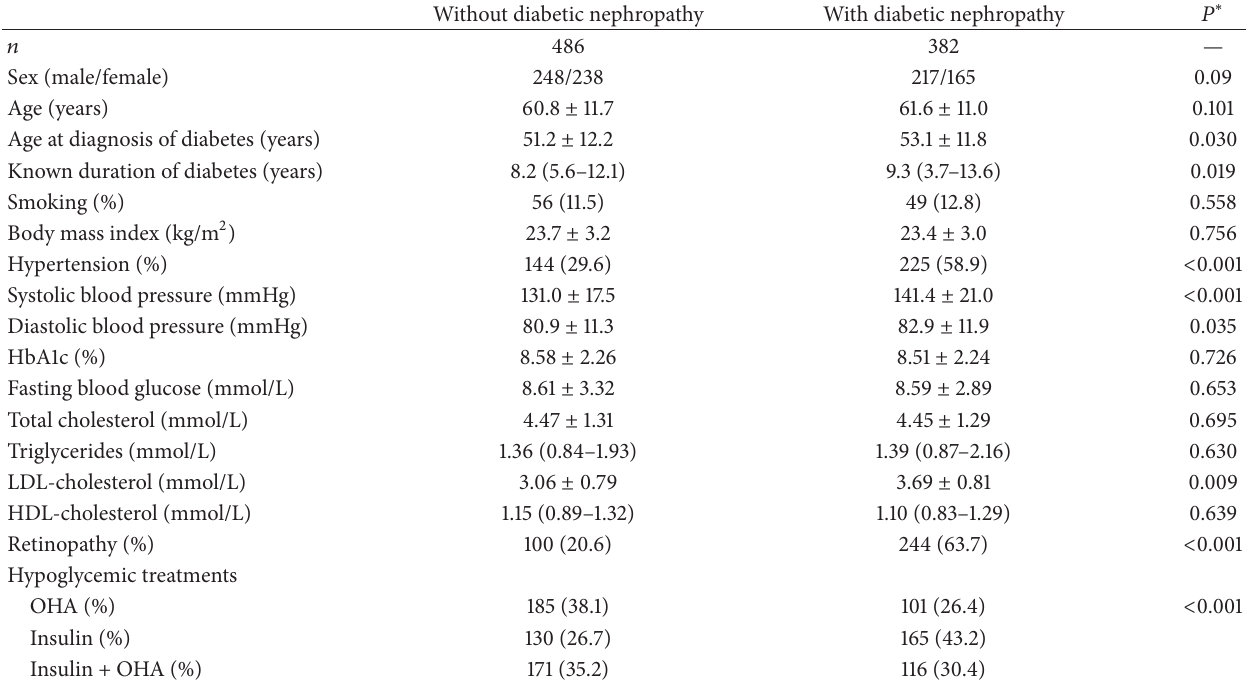
Table 1: Clinical and laboratory characteristics of patients with type 2 diabetes with and without diabetic nephropathy. Without diabetic nephropathy With diabetic nephropathy 𝑃